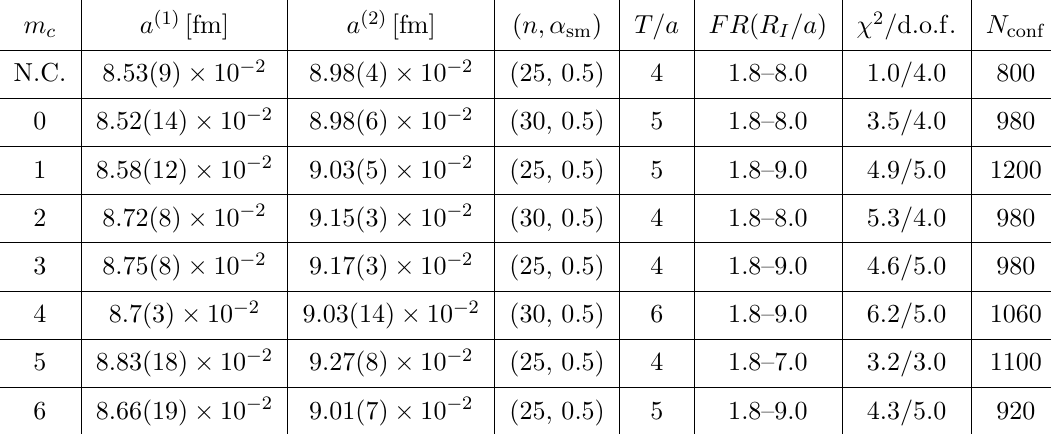
Table 2 . The numerical results of the lattice spacing a (1) and a (2) . The lattice is V = 18 3 (cid:2) 32, (cid:12) = 6 : 0522. N.C. stands for the normal con(cid:12)guration. The number of iterations and the weight factor for the smearing are written as ( n; (cid:11) sm ). T=a indicates the temporal component of the Wilson loop, which we determine with the lattice spacing. FR indicates the (cid:12)tting